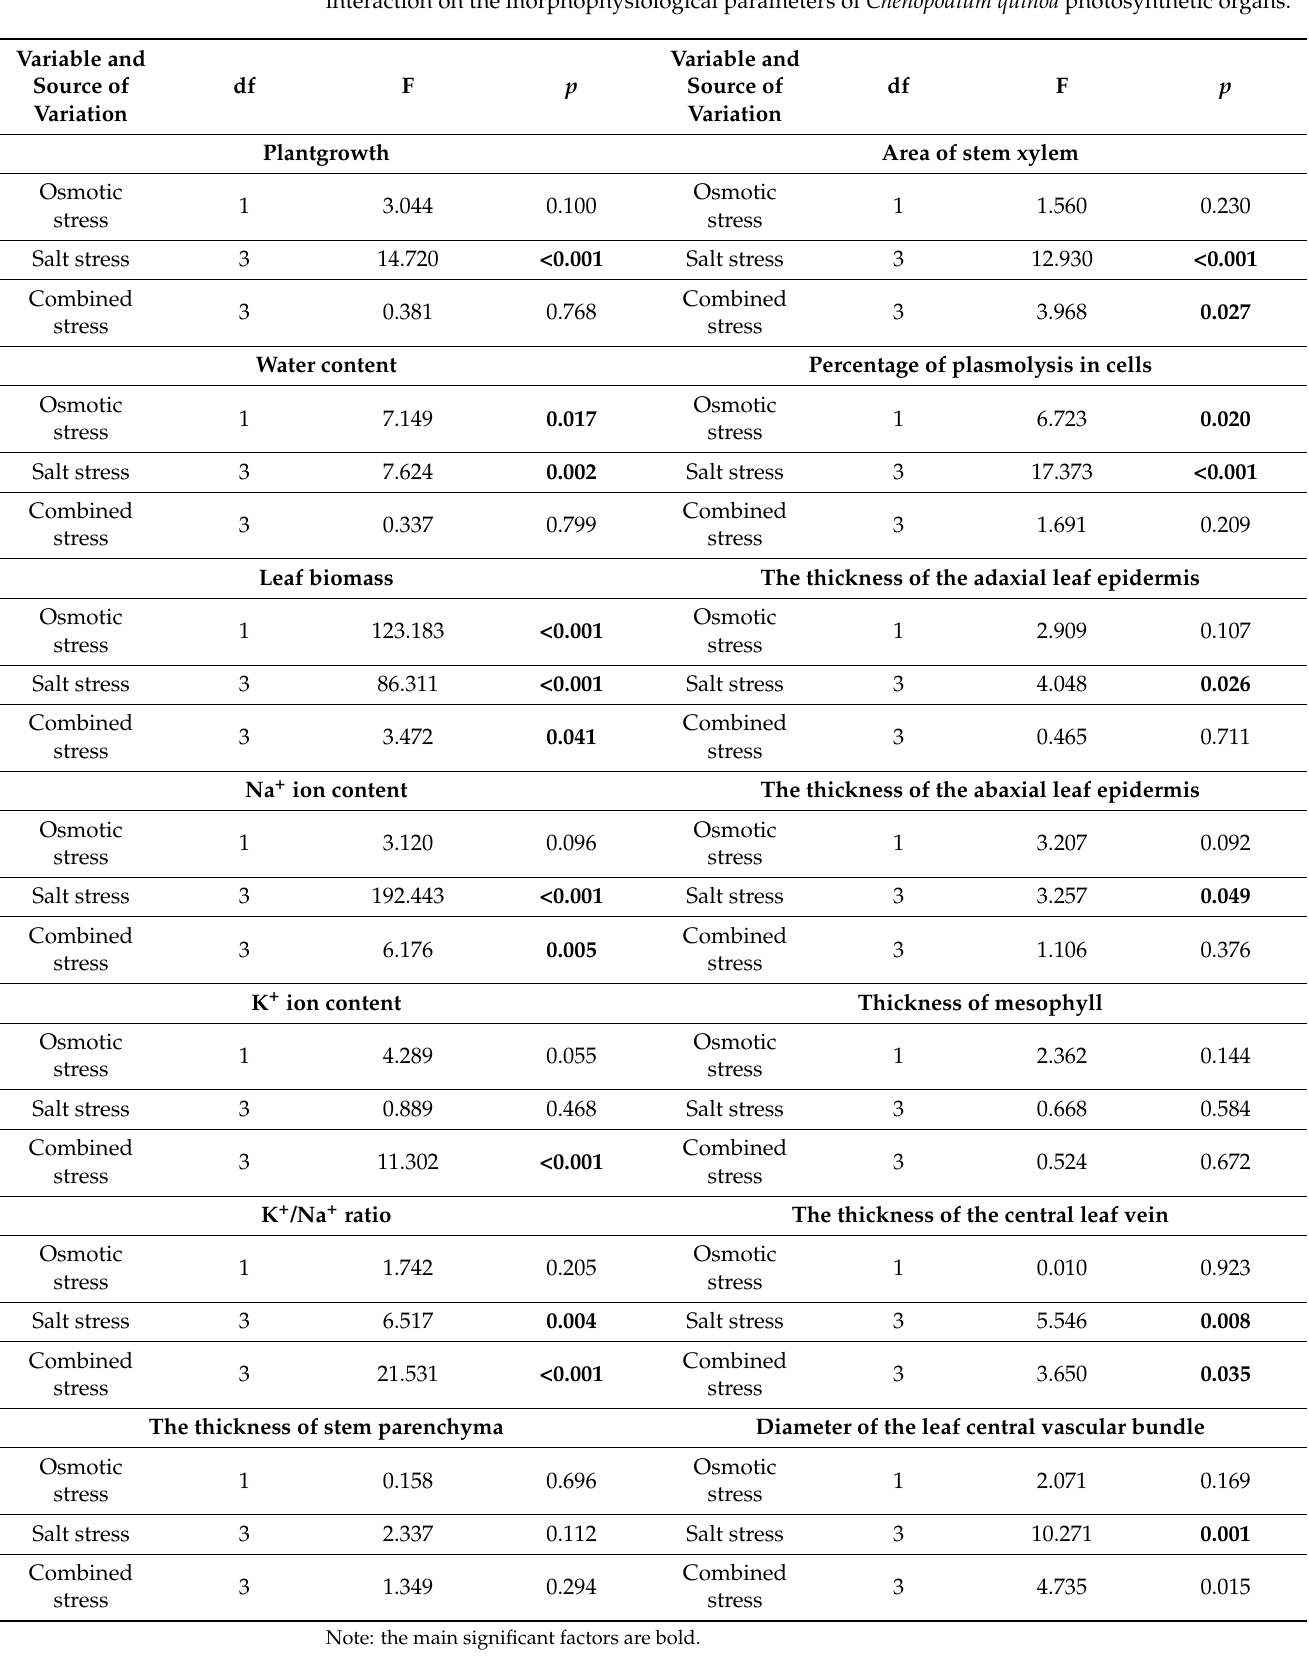
Table 2. A two-way ANOVA shows the effect of the main factors (salinity and osmotic stress) and their interaction on the morphophysiological parameters of Chenopodium quinoa photosynthetic